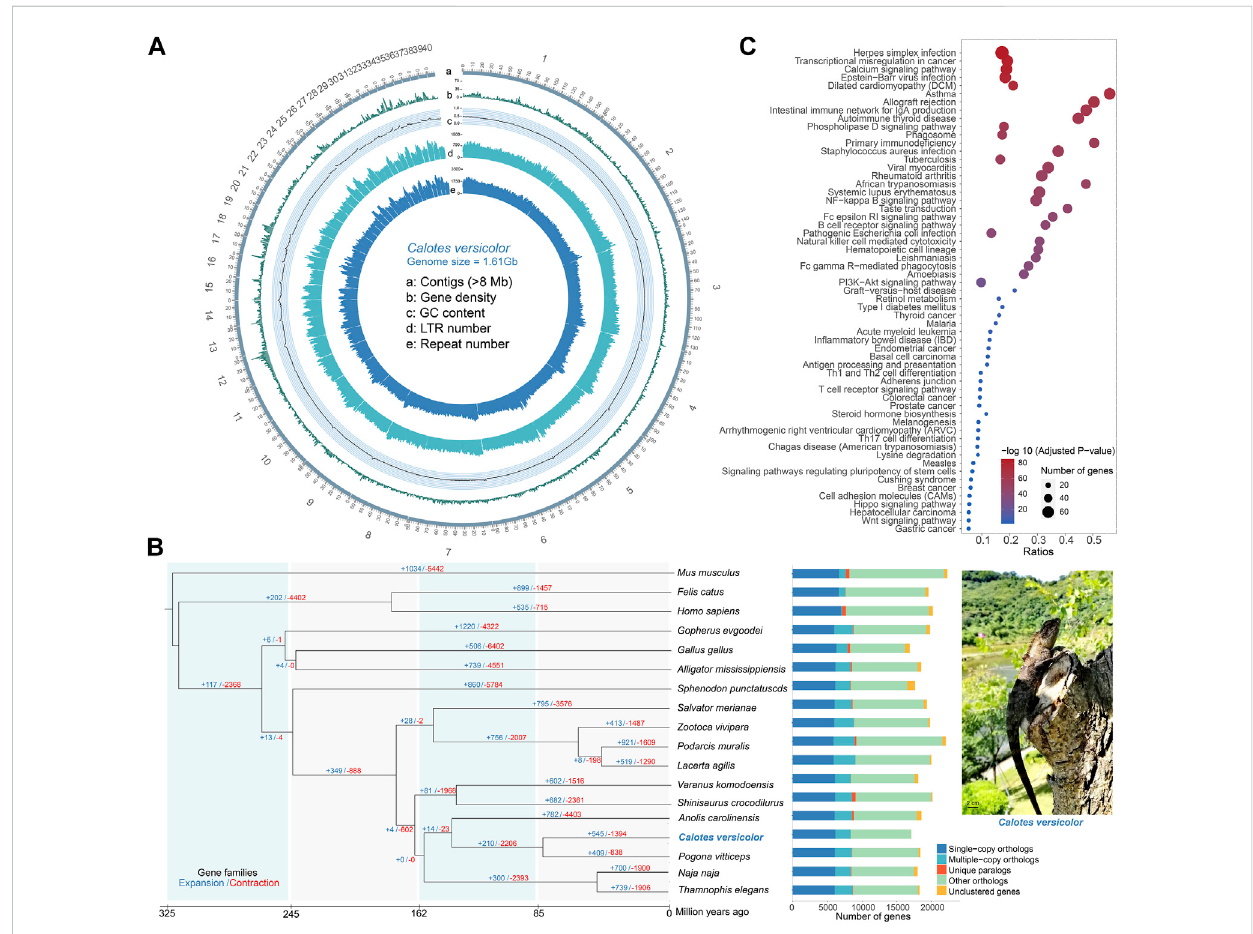
FIGURE 1 Genome landscape of the Calotes versicolor genome, comparative genomics analysis and enrichment analysis of expanded gene families. (A) Genomic features landscape of the C. versicolor genome (500 kb window). a: 40 contigs (92.63% of the genome) with a length range from 8.67 Mb to 160.80 Mb.b:genecount(0 – 61).c:GCcontentdensity(0.0011 – 0.6632).d:LongTerminalRepeats ( LTR)count(0 – 1464).e:repeatdensity(2 – 3482). (B) Thephylogeneticrelationshipof17speciesandtheestimateddivergencetime.Genefamilyexpansions(+)andcontractions( − )areindicatedbyblue and red colors, respectively. The stacked bar plot presents the number of orthologous for 17 species. The right fi gure is adult of C. versicolor . (C) Signi fi cantly enriched 59 Kyoto Encyclopedia of Genes and Genomes (KEGG) pathwaysin the C. versicolor genome compared with the other 16